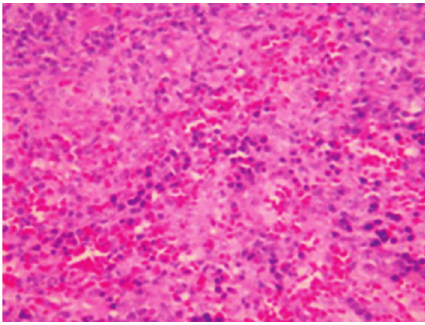
Figure 9: Sham-operated group 28 days; hyperplasia of cells in the splenic sinus, enlargement of blood sinus, inflammatory cell infiltration, and hemorrhage; HE × 200.